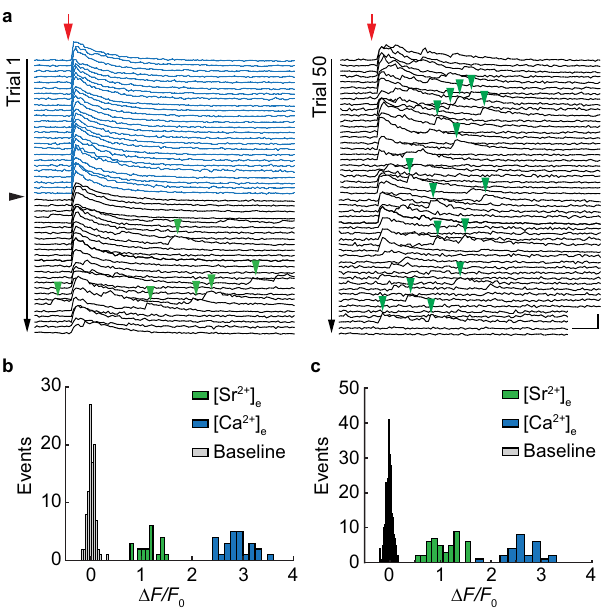
Fig.3|Desynchronizedglutamatereleaseeventsrevealquantalsize.a iGluSnFR changes in fl uorescence (single bouton) in response to single APs in ACSF con- taining 4mM [Ca 2+ ] e (blue traces). Red arrow indicates stimulation onset. Synaptic release probability was 1 (no failures). The black arrowhead indicates the start of 4mM [Sr 2+ ] e wash-in. During wash-in of 4mM [Sr 2+ ] e discrete events appear in the wakeofthestimulation(greenarrowheads).Scalebars:20ms,2 Δ F / F 0 . b Amplitude histogram of evoked responses measured in 4mM [Ca 2+ ] e (blue bars) and delayed events measured in 4mM [Sr 2+ ] e (green bars) and fl uctuation of baseline fl uores- cence (gray bars) of the example shown in a . c Second example. Baseline fl uctua- tions are plotted with narrow bin size to show their normal distribution. Source data are provided as a Source Data fi